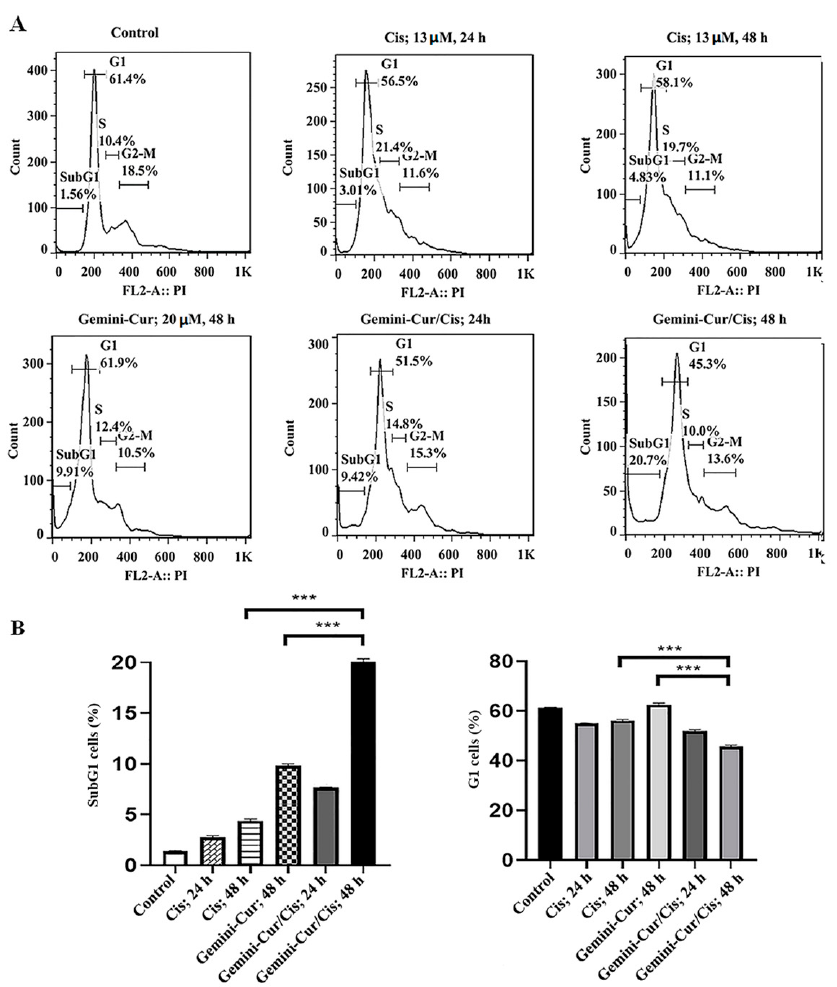
Figure 4. Analysis of cell cycle by flow cytometry in cancer cells treated with 13 µ M cisplatin and 20 µ M Gemini-Cur for 24 & 48 h. ( A ) Histograms for MDA-MB-231 cells. ( B ) The percentage of cells in sub-G1 and G1 phases. The data clearly illustrate an increase in the number of SubG1 cells in combination treatment compared to either void cisplatin or Gemini-Cur. Accordingly, the number of live cells is decrease in Gemini-Cur/Cis group versus Gemini-Cur and Cis groups. Data represent mean ± standard deviation of three independent experiments. (*** p <